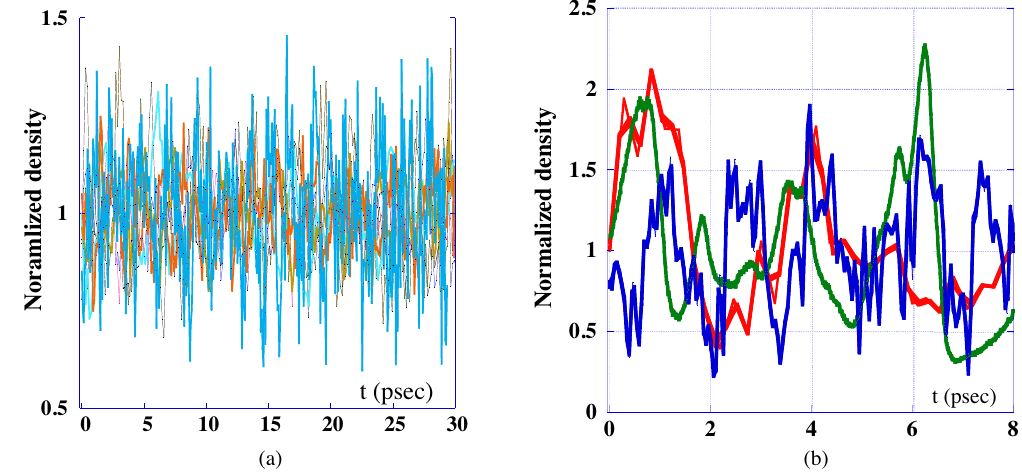
FIG. 17. (a) A 30-psec section of nine measured normalized density profiles. (b) An 8-psec section of three density profiles: SPACE - code simulation (green), measured with 100 kV linac voltage (red) and 200 kV linac voltage